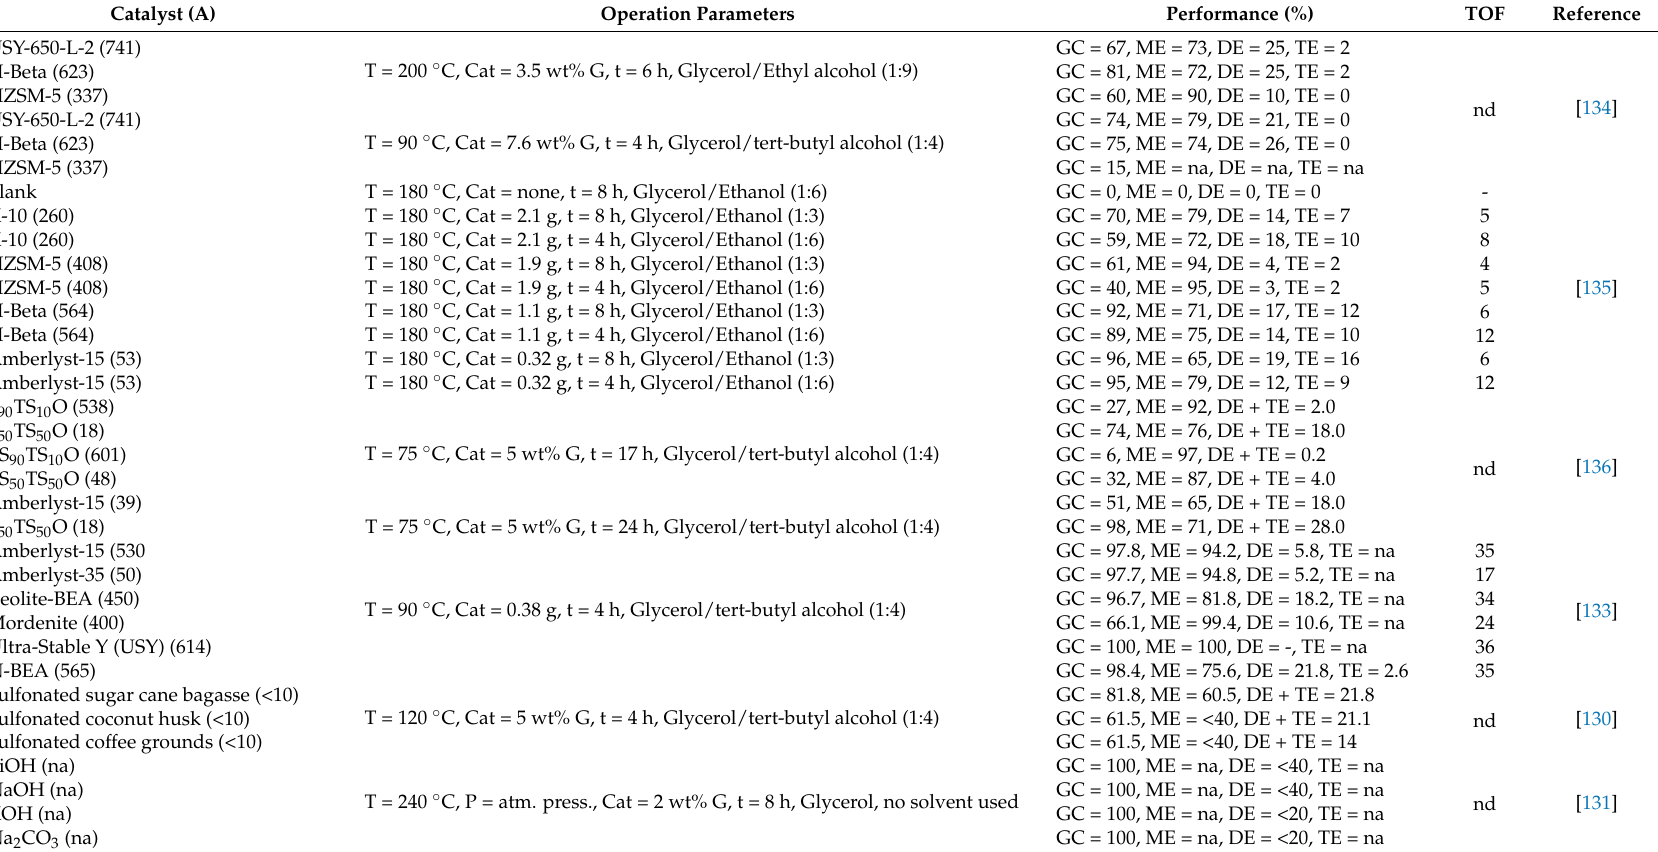
Table 9. Performance of some catalysts in the conversion of glycerol to glycerol ethers as reported in some